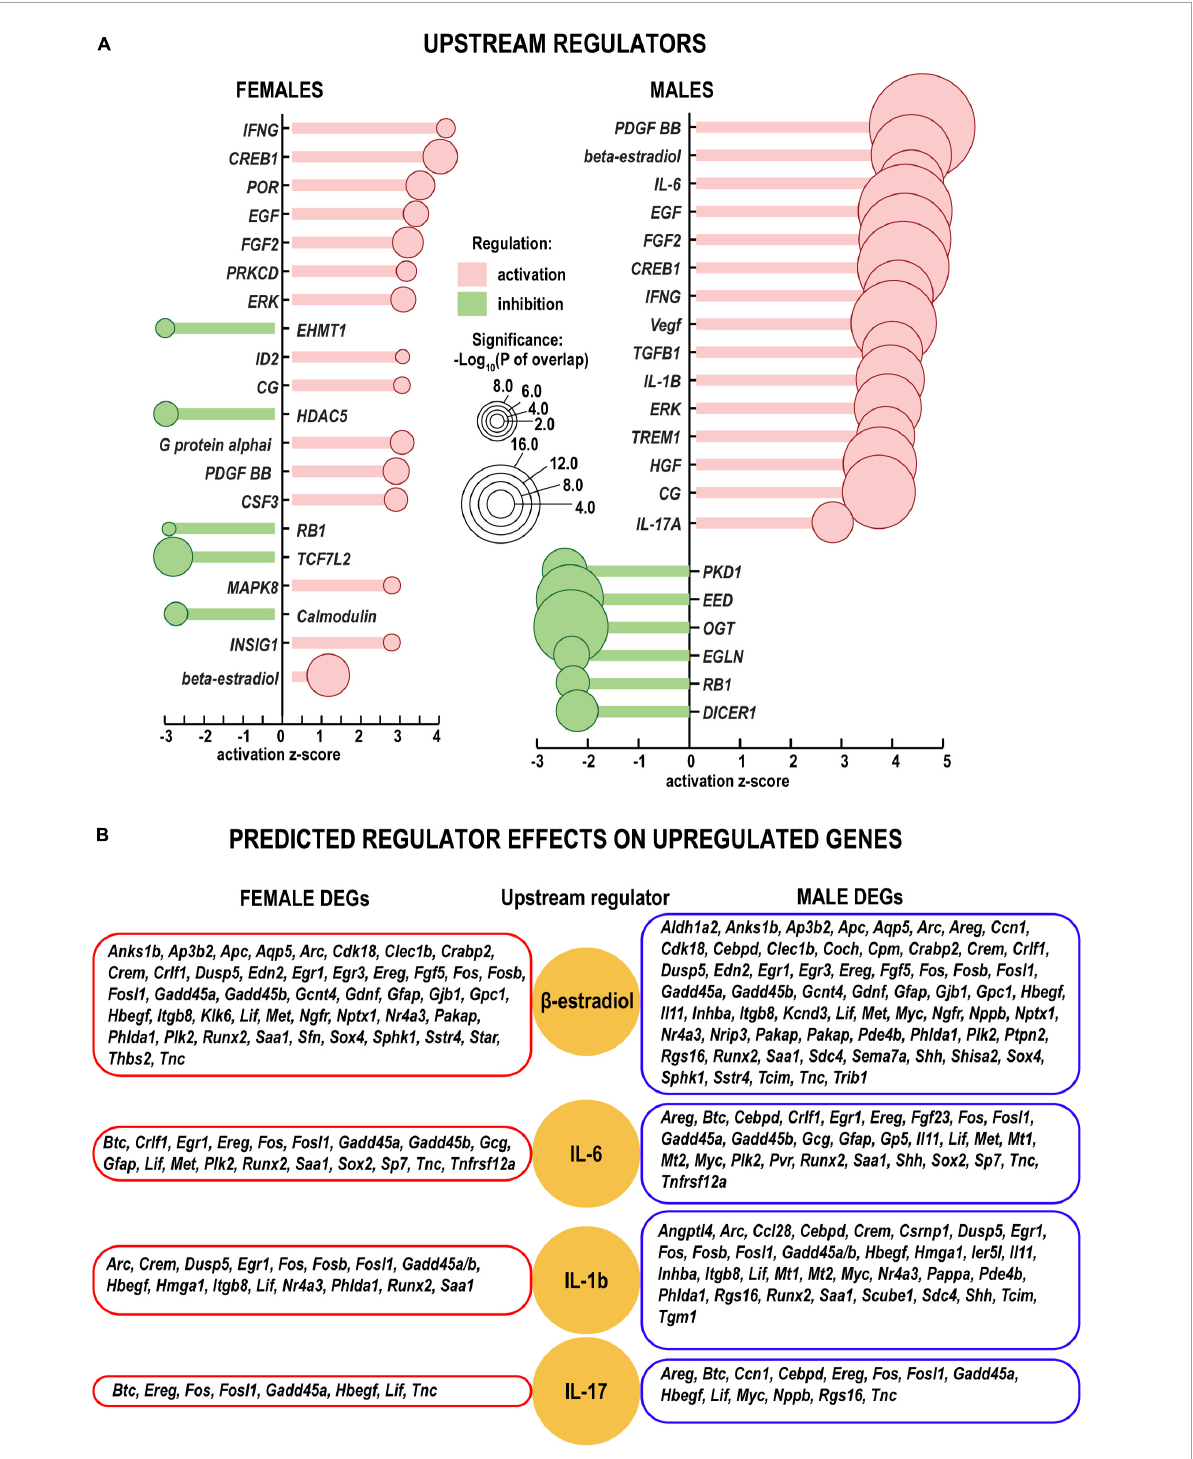
FIGURE5 Upstream regulators of the injury response in distal nerve segments. (A) Activation (positive z, red color) and inhibition (negative z, green color) z-scores indicate IPA-predicted regulator effects to upregulate or downregulate respective DEGs. Circle diameters correspond to the p –values [as –log 10 (P) according to a significance scale] that measure the statistical significance of the overlap between the dataset DEGs and all genes regulated by a given regulator calculated using Fisher’s exact test in IPA. (B) Upregulation of DEGs in females (left panels) and males (right panels) (log 2 FC > 1, P adj < 0.1). Yellow circles correspond to select upstream regulators (beta-estradiol, IL-6, IL-1b, and IL-17) predicted by IPA. All predicted upstream regulators are included in Supplementary Table 2